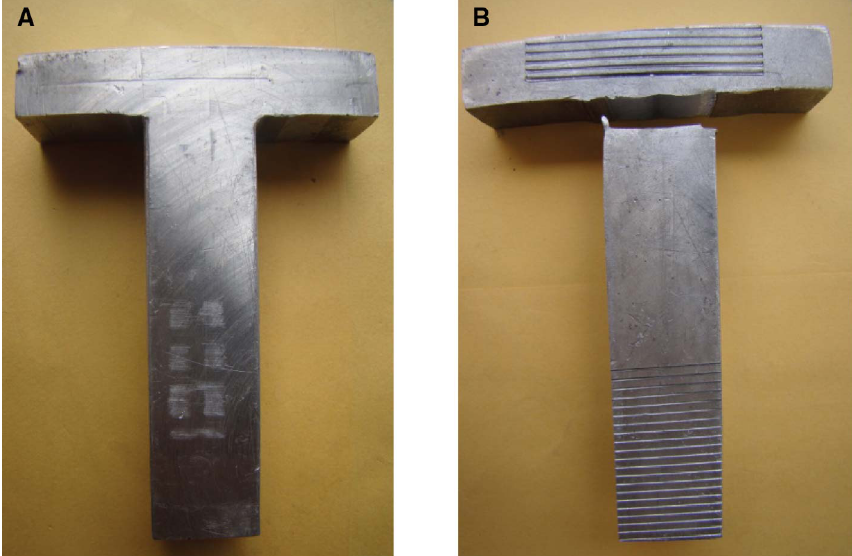
Figure 7: (A) T-joint before testing. (B) T-joint after